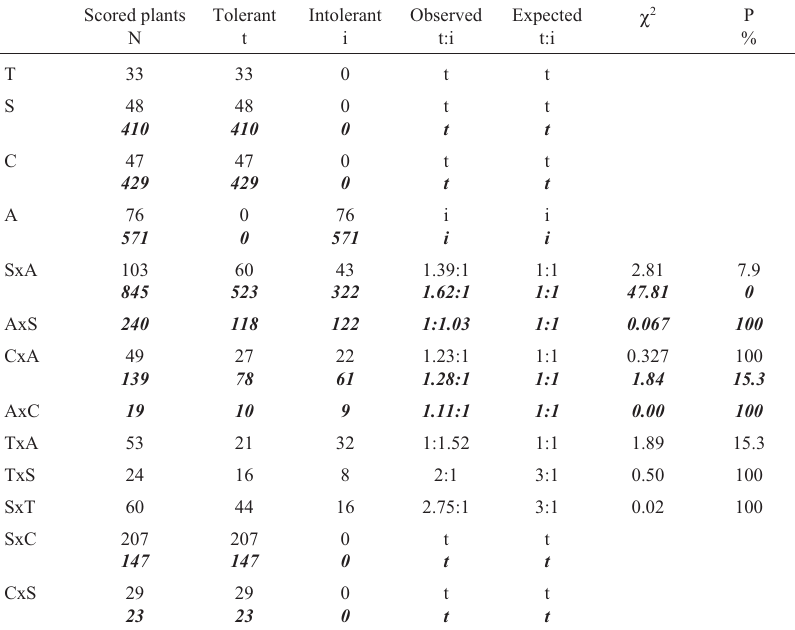
Table2 -Reactiontotristezadisease.Number(n)oftolerant(t)andintolerant(i)plantsinthegenitorsTrifoliata(T),Sunki(S),Cravo(C),Azeda(A)and their hybrids scored in the plots COS I and COS II. The observed and expected ratios, the Chi-square ( χ 2 ) values (corrected for continuity) and the corresponding probabilities (in percent) are also shown. The values for COS II plots are shown in bold italics. Scored plants Tolerant Intolerant Observed N t i